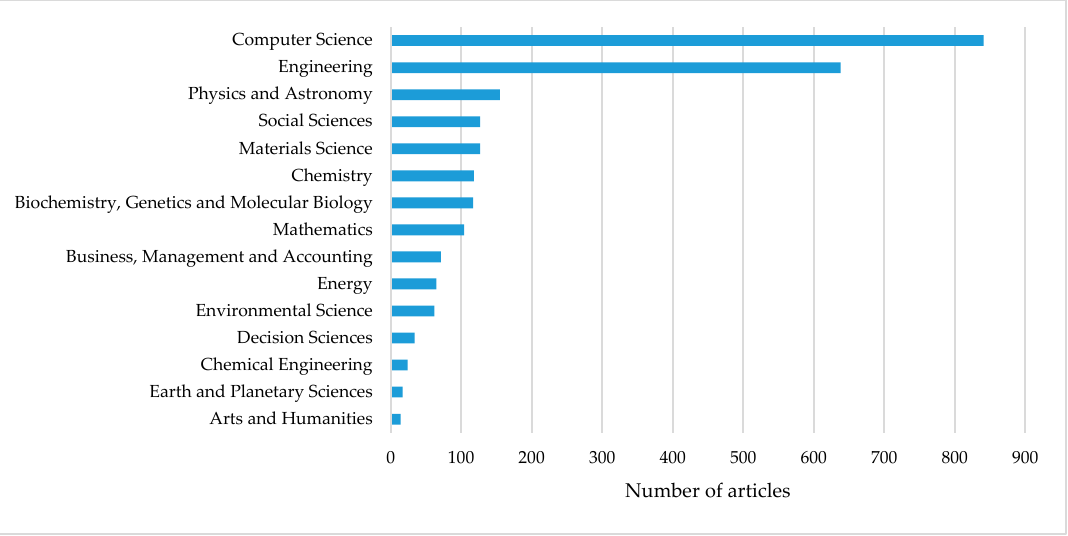
Figure 3. Top 15 subject areas (2011–2019).